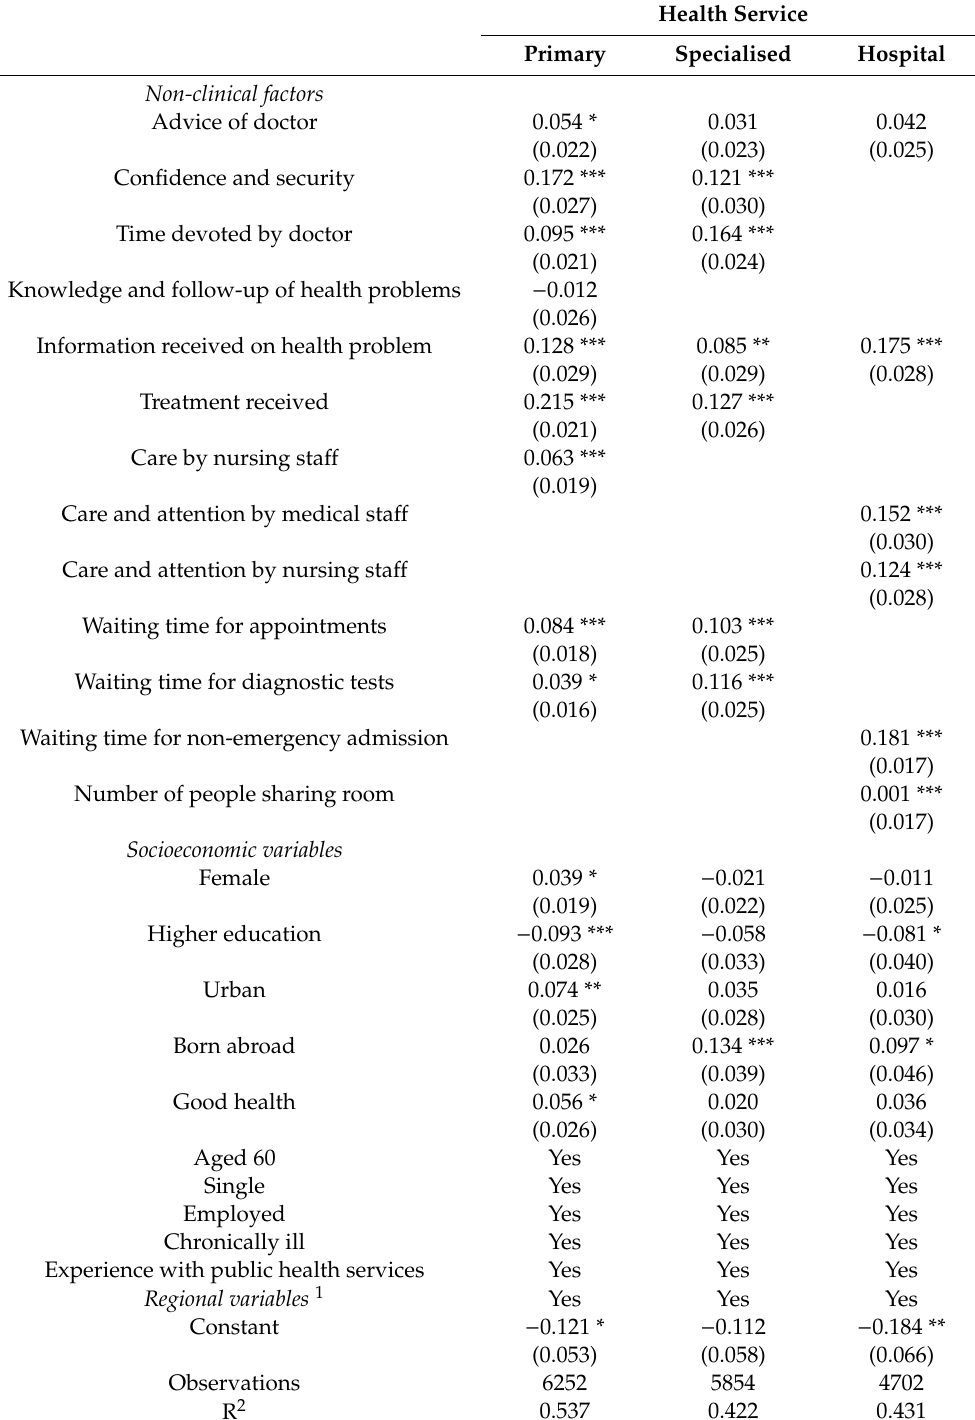
Table 6. Determinants of overall self-reported experience with the Spanish public health services in